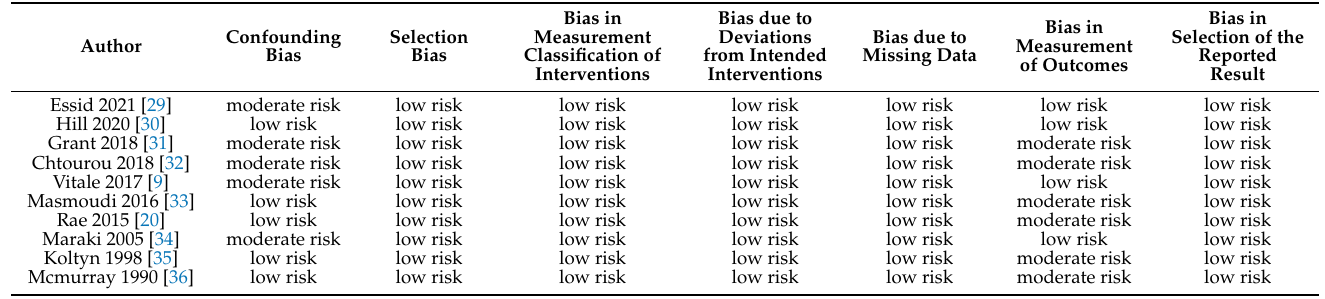
Table 1. Risk of bias assessment for non-randomized controlled